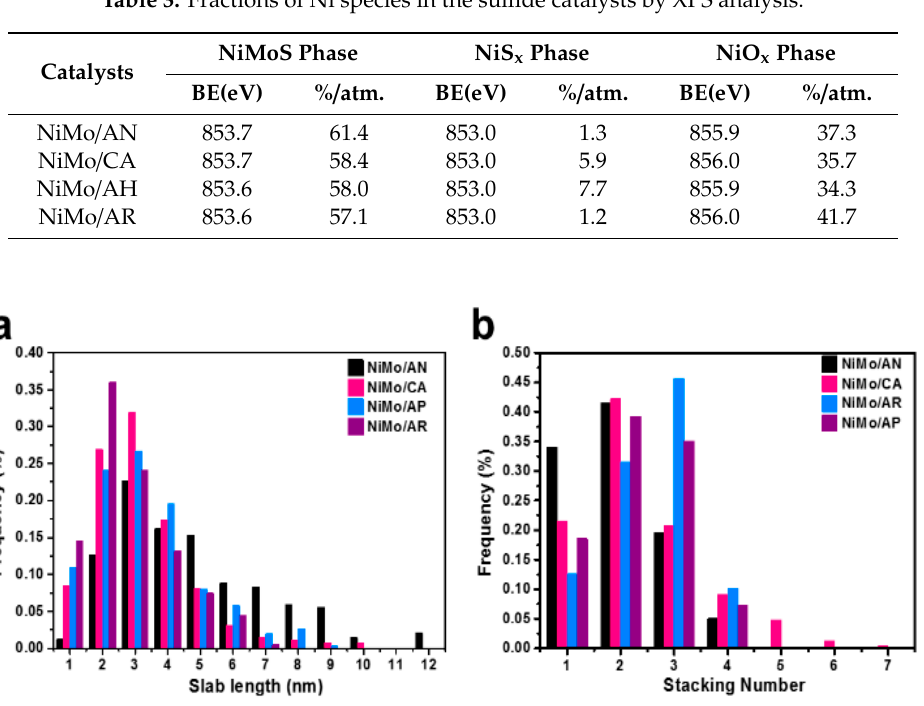
Table 3. Fractions of Ni species in the sulfide catalysts by XPS analysis.